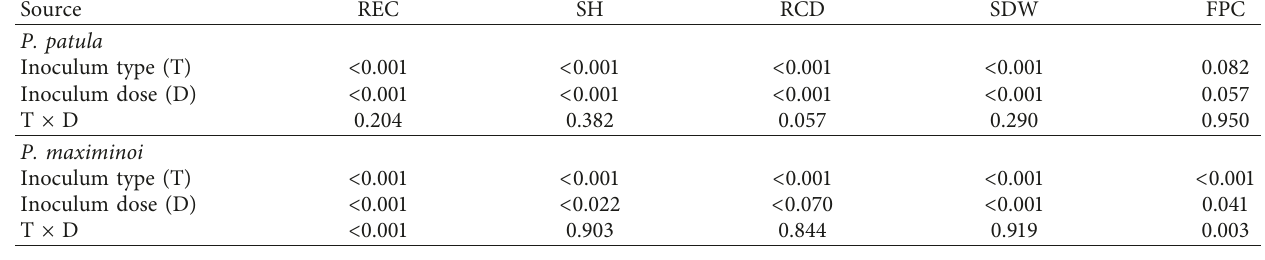
Table 1: P values of the ANOVAs for shoot height (SH), root collar diameter (RCD), shoot dry weight (SDW), root ectomycorrhizal colonization (REC), and foliar P content (FPC) of P. patula and P. maximinoi seedlings under the different treatments